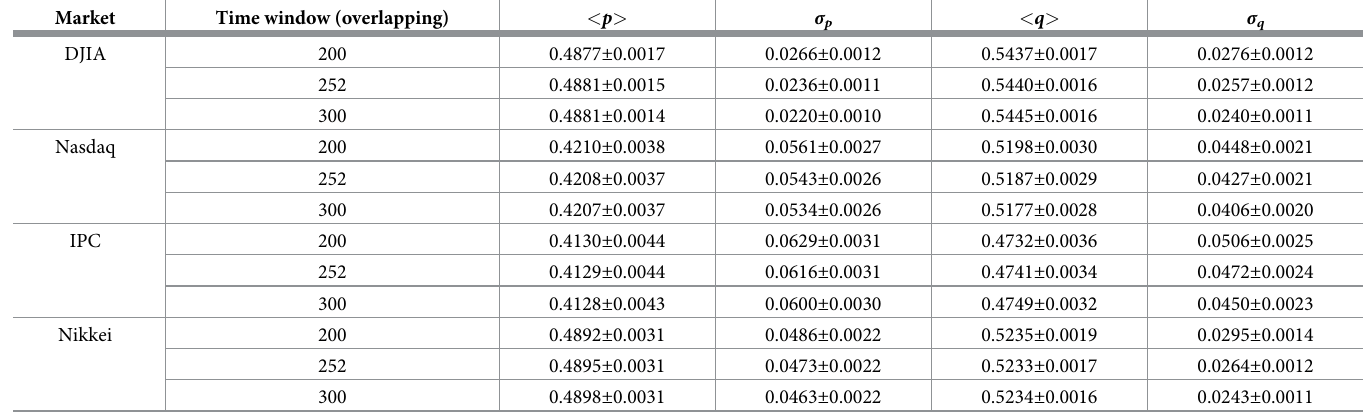
Table 8. Mean and standard deviation values of p and q distributions shown in Fig 5, and generated with a rolling, overlapping time window of 252 days. Same values generated for two additional overlapping time frames of 200 and 300 days are also displayed. Market